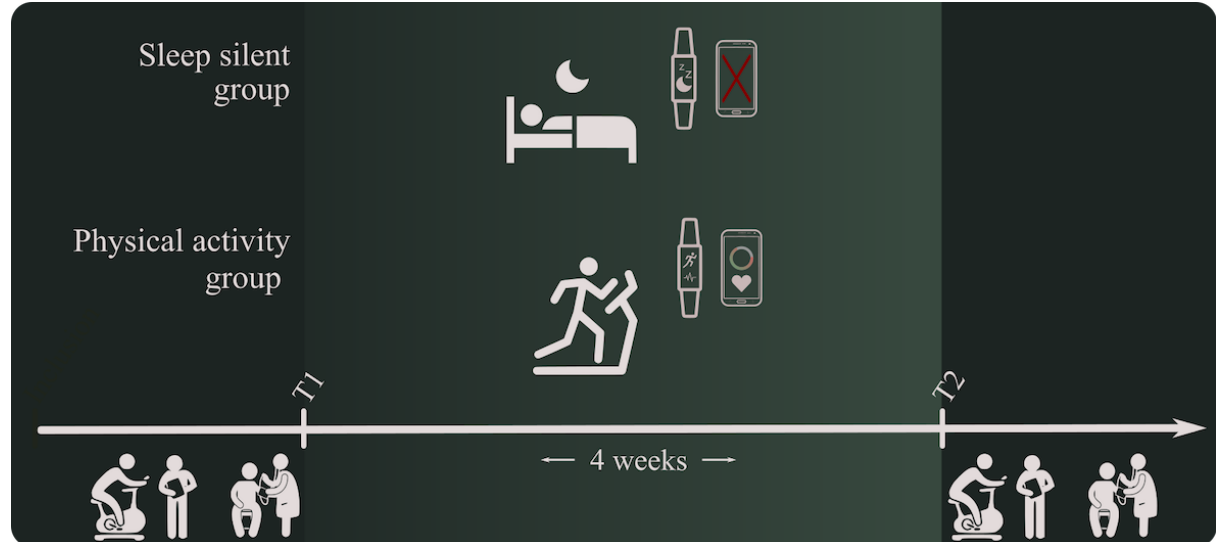
Figure 1. Experimental